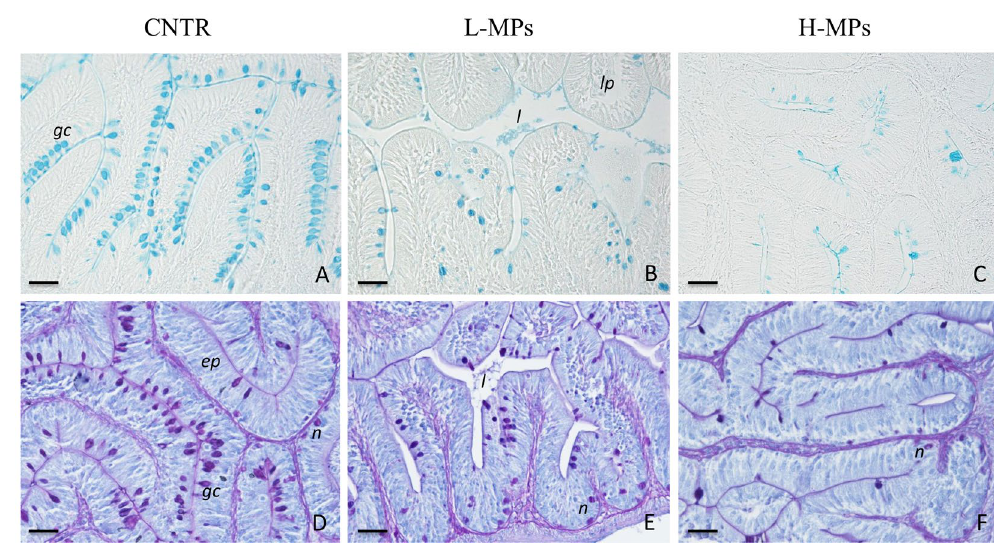
Figure 4. Histology of gastrointestinal tract (GIT). Representative sections of intestines stained with AB ( A–C ) or PAS with HH nuclear counterstain ( D–F ). CNTR (Control) in ( A,D ); L-MPs (100 µ g/L) in ( B and E ); H-MPs (1000 µ g/L) in ( C,F ). Gc : goblet cells; l : lumen; lp : lamina propria; ep: epithelium; n: neutrophils. Scale bar: 50 µ